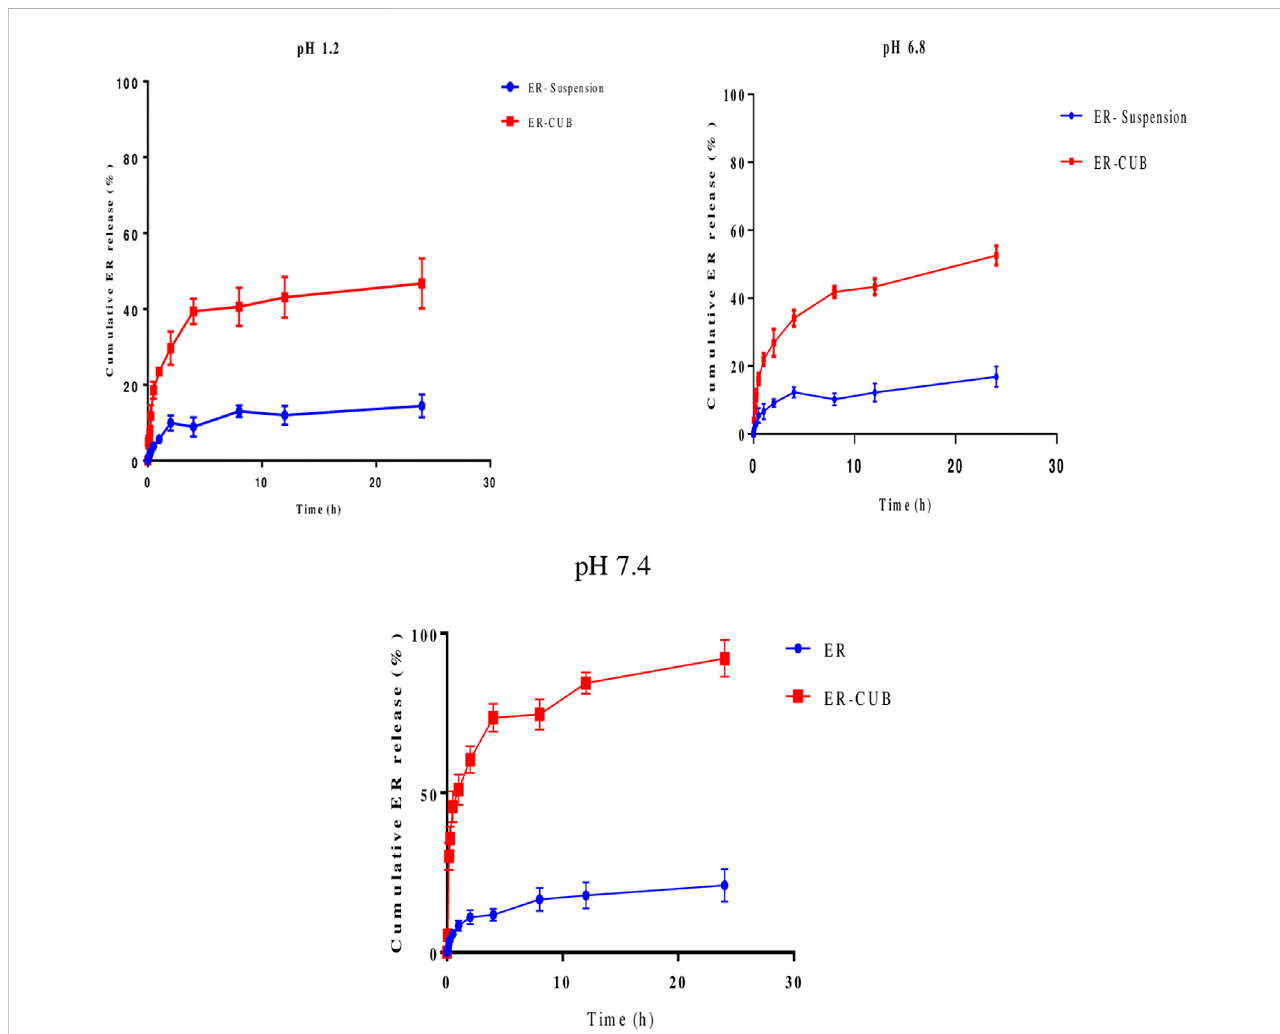
FIGURE 6 Invitro releaseofpureERandER-CUBusingdialysisbagsmethod.Thereleasestudywasperformedat37 ° Cat100 rpmin0.1NHCl,PBS(pH6.8and7.4), values are mean±SD (n=3). The release ER fabricated formulation exhibited controlled release compared to pure ER ( p < 0.05) at different time